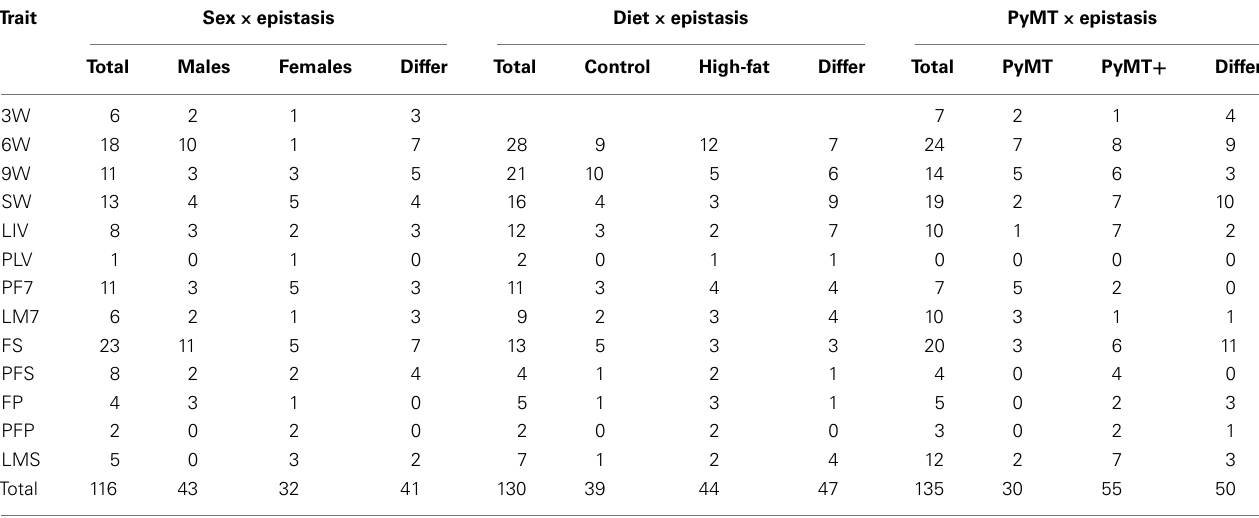
Table 2 | Summary of sex, diet, and PyMT by epistasis interactions affecting the weight and adiposity traits. Trait Sex × epistasis Diet × epistasis PyMT ×